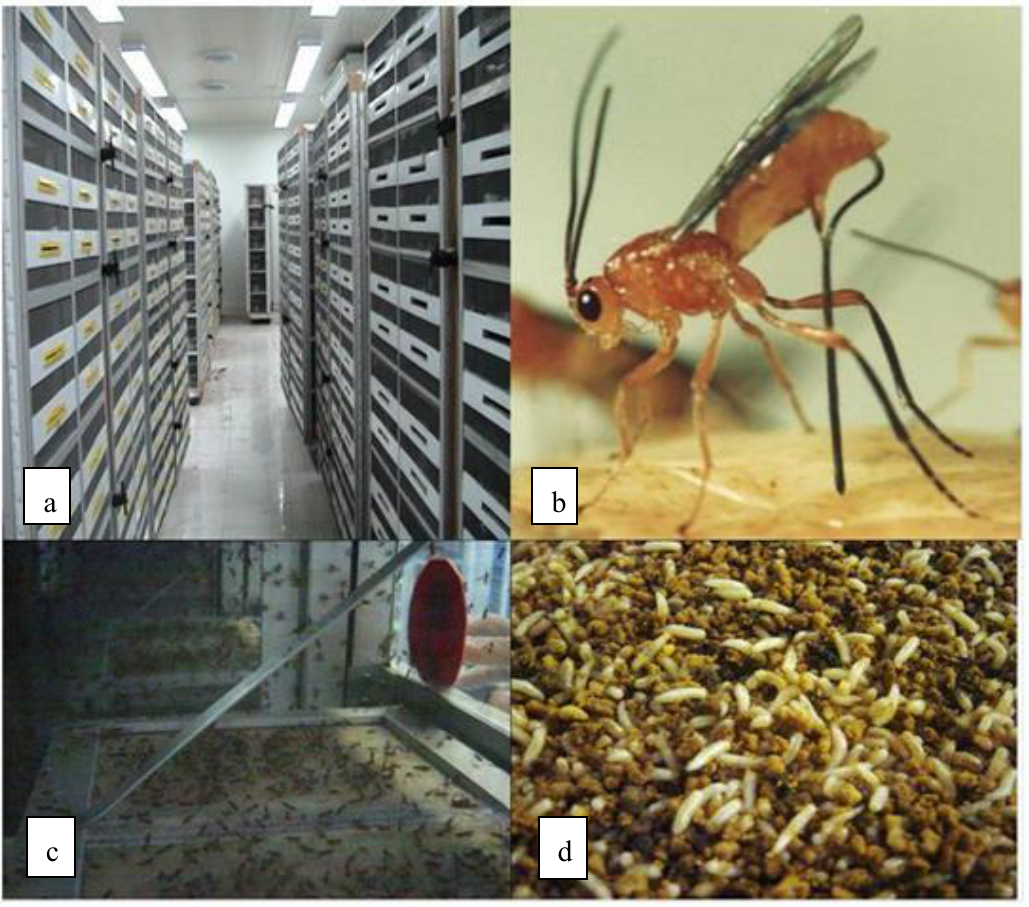
Figure 1. Mass rearing of D. longicaudata with irradiated host larvae. Moscafrut Program, México. ( a ) Cages in the adult colony, ( b ) D. longicaudata female ovipositing, ( c ) an adult parasitoid rearing cage, ( d ) larvae that have been exposed to parasitoids, including pupated